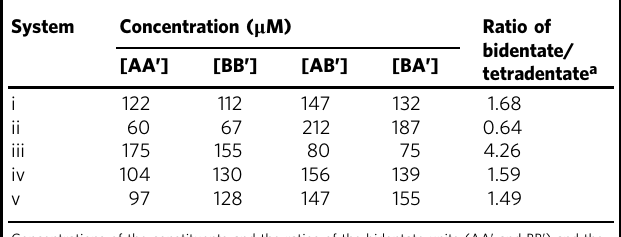
Concentrations of the constituents and the ratios of the bidentate units (AA ’ and BB ’ ) and the tetradentate unit (AB ’ /BA ’ ) in the CDNs: (i) CDN X ; (ii) CDN Y ; (iii) CDN Z ; (iv)